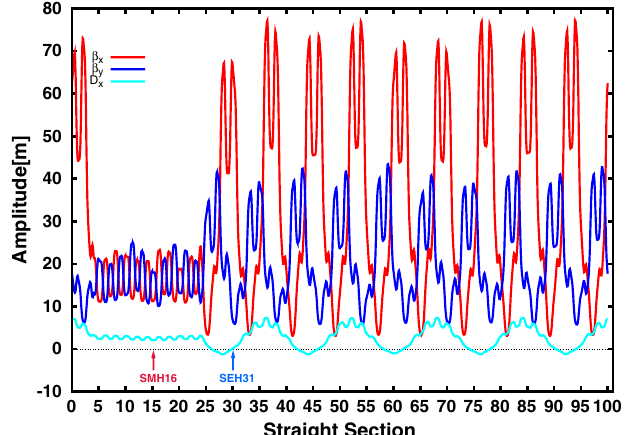
FIG. 5. PS optics distorted by the QKE16. The region at small horizontal and vertical (cid:1) is between SS05 and SS25. The locations of SMH16 and SEH31 are pointed out.